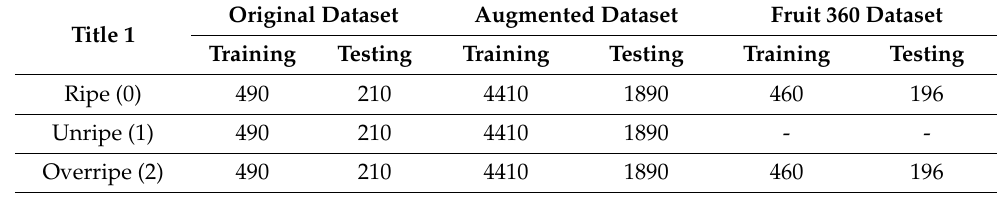
Table 2. Original, augmented, and Fruit 360 dataset information.